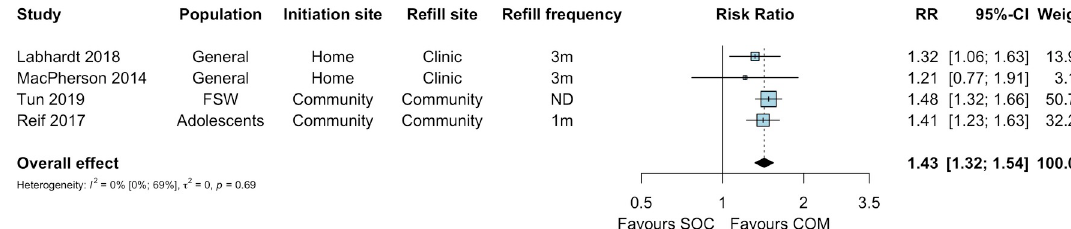
Fig 5. ART retention at 6–12 months among HIV-positive individuals, by implementation strategy. COM, community ART initiation; FSW, female sex workers; ND, not determined; RR, risk ratio; SOC, standard of care. MacPherson 2014 reflects cluster- adjusted numbers based on the Cochrane method of adjusting for the design